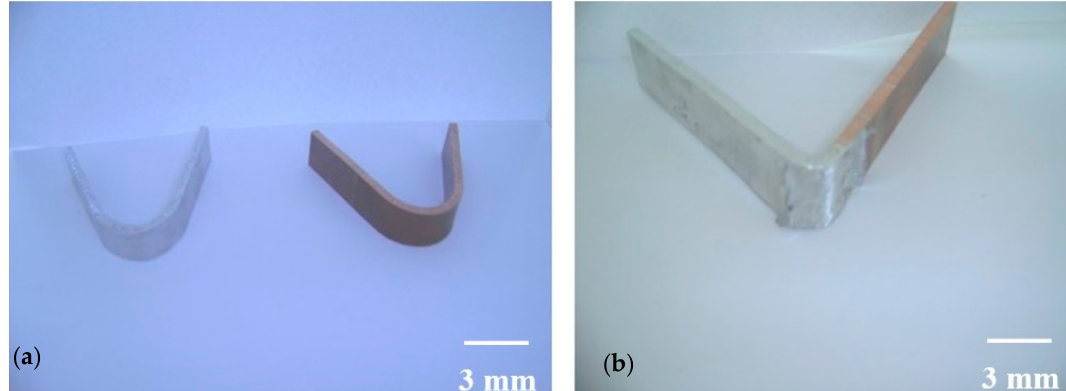
Figure 11. Bending test results of ( a ) base materials, ( b ) welded parts.